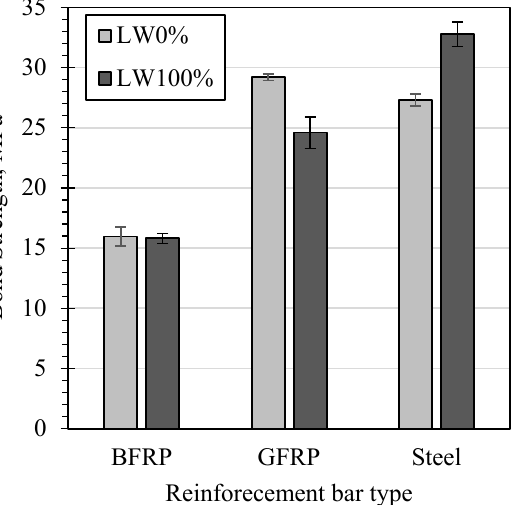
Figure 9. Comparing the bond stress–slip curves between the experiment and numerical modeling.